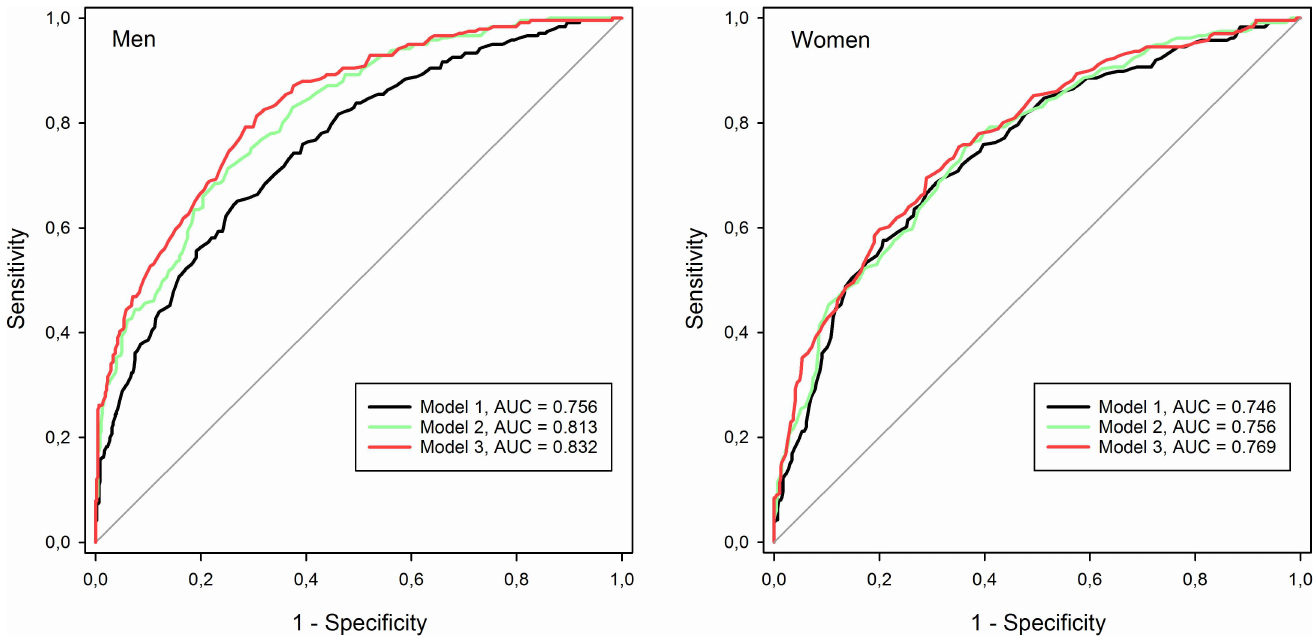
Fig 3. Performance of models identifying subjects with VO 2peak in lower